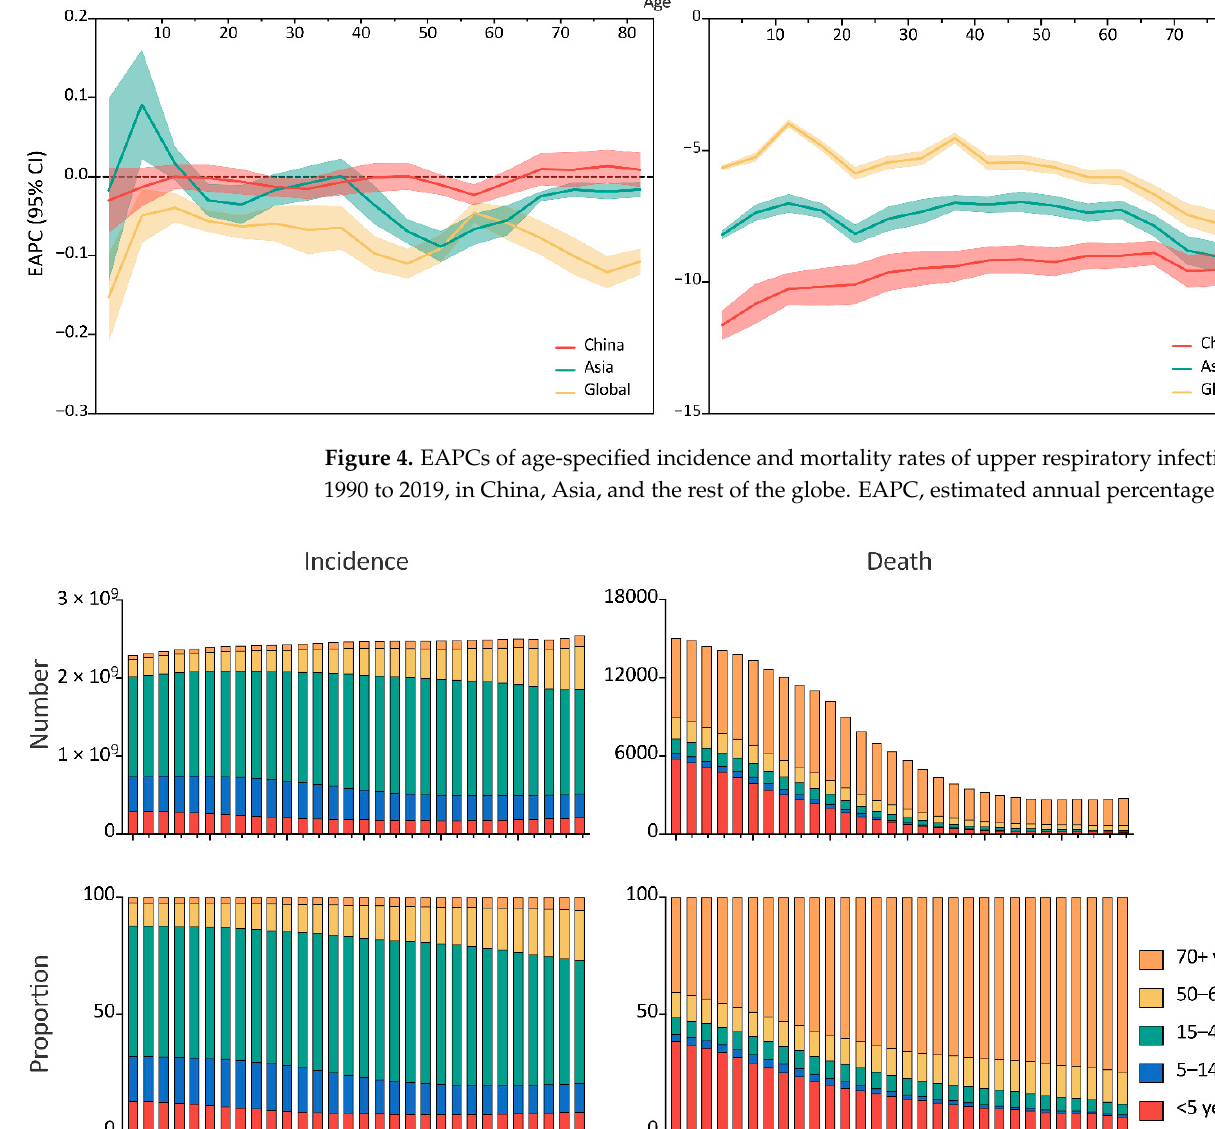
Figure 3. The number of upper respiratory infection cases and deaths by sex, from 1990 to 2019, in China, Asia, and the rest of the globe.